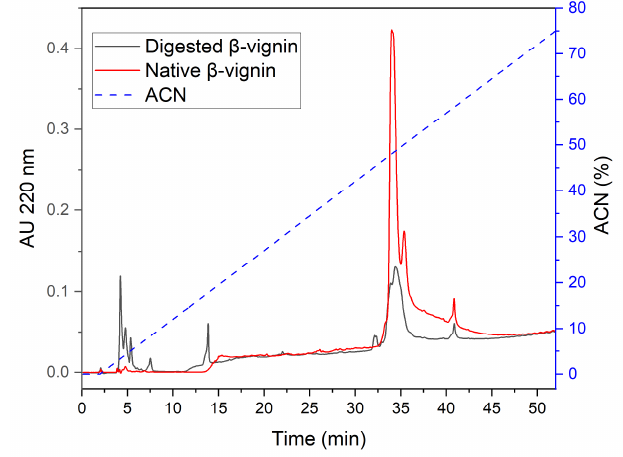
Figure 9. RP-HPLC of the native (red line) and digested (black line) β -vignin. Dashed blue line refers to acetonitrile (ACN) concentration gradient.